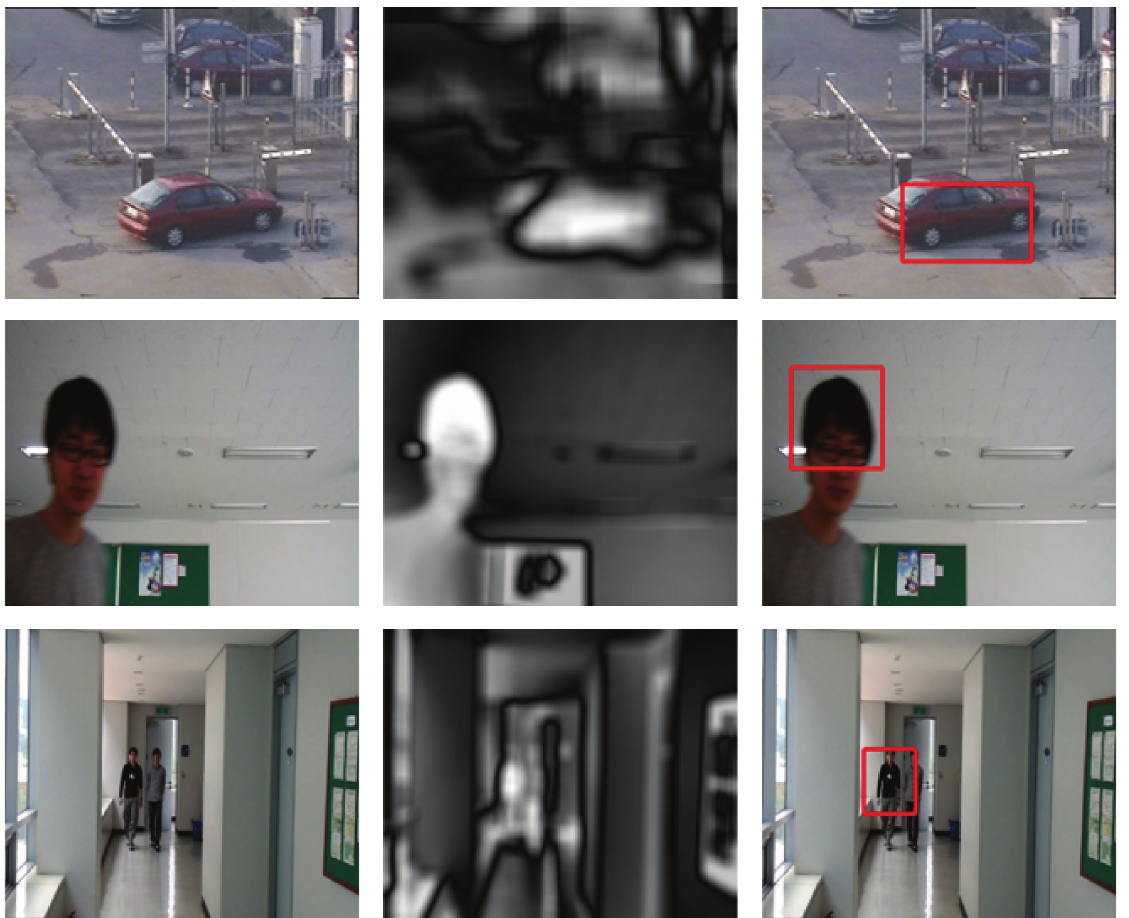
Figure 15: Videos (3) and (4): results of modified frequency tuned spatial model